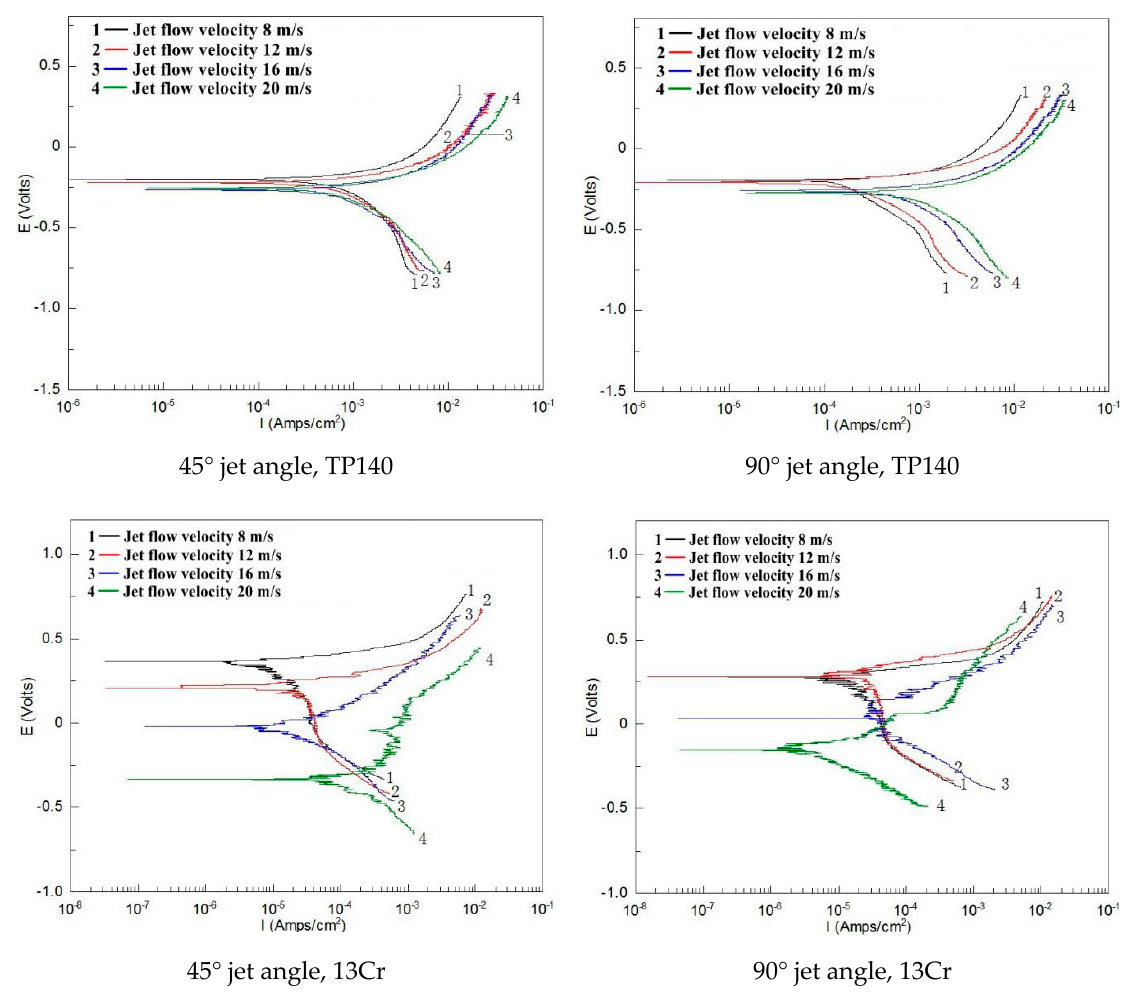
Figure 8. Polarization curves of TP140 and 13Cr with angles 45° and 90° (2 wt % NaCl + sand). Table 4. Summary of experimental measurements of erosion and corrosion components (mm/a).